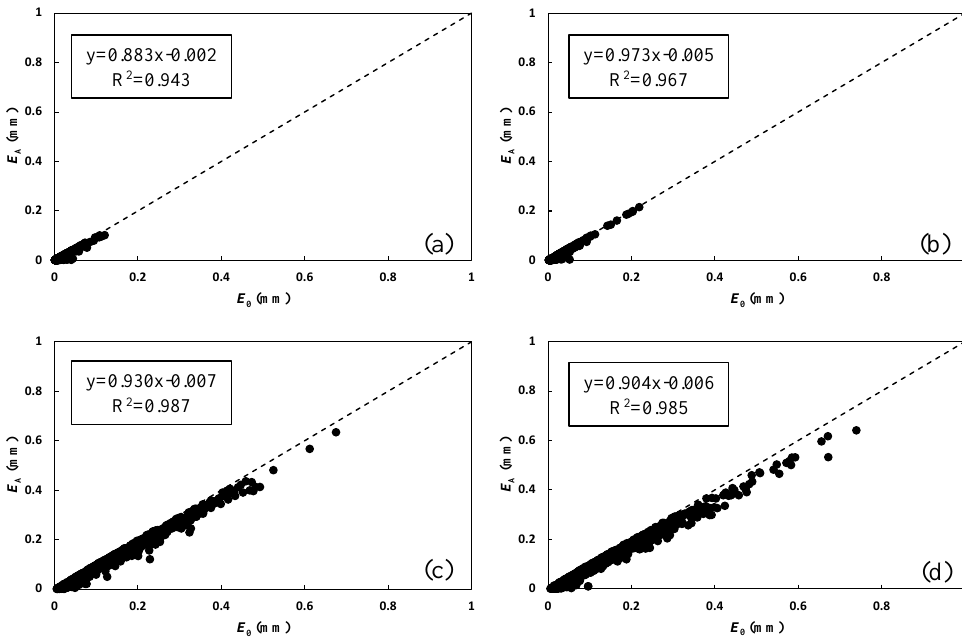
Figure 6. E A versus E 0 from scintillometer using the proposed linearized β method in January and February, 2013 (a, e) , May and June, 2013 (b, f) , July and August, 2014 (c, g) , and November and December, 2012 (d, h) .